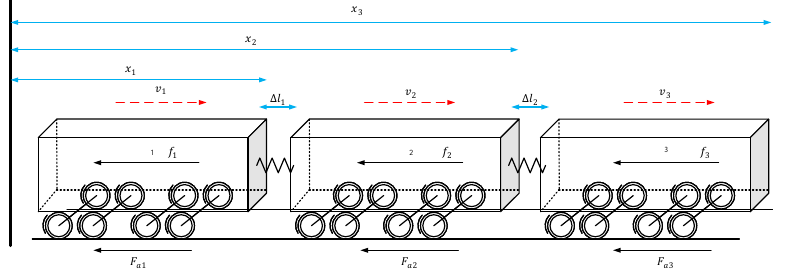
Figure 1. The dynamics of an urban railway train during braking. The additional resistance f ci is derived from the rail curvatures, slopes, and tunnels. It can be denoted by [23] where the first and second terms represent the influences of the track slope and track curvature, respectively. The parameter θ ci denotes the track slope angle, and the parameter D ci denotes the curvature degree. Nomenclatures are summarized in Table